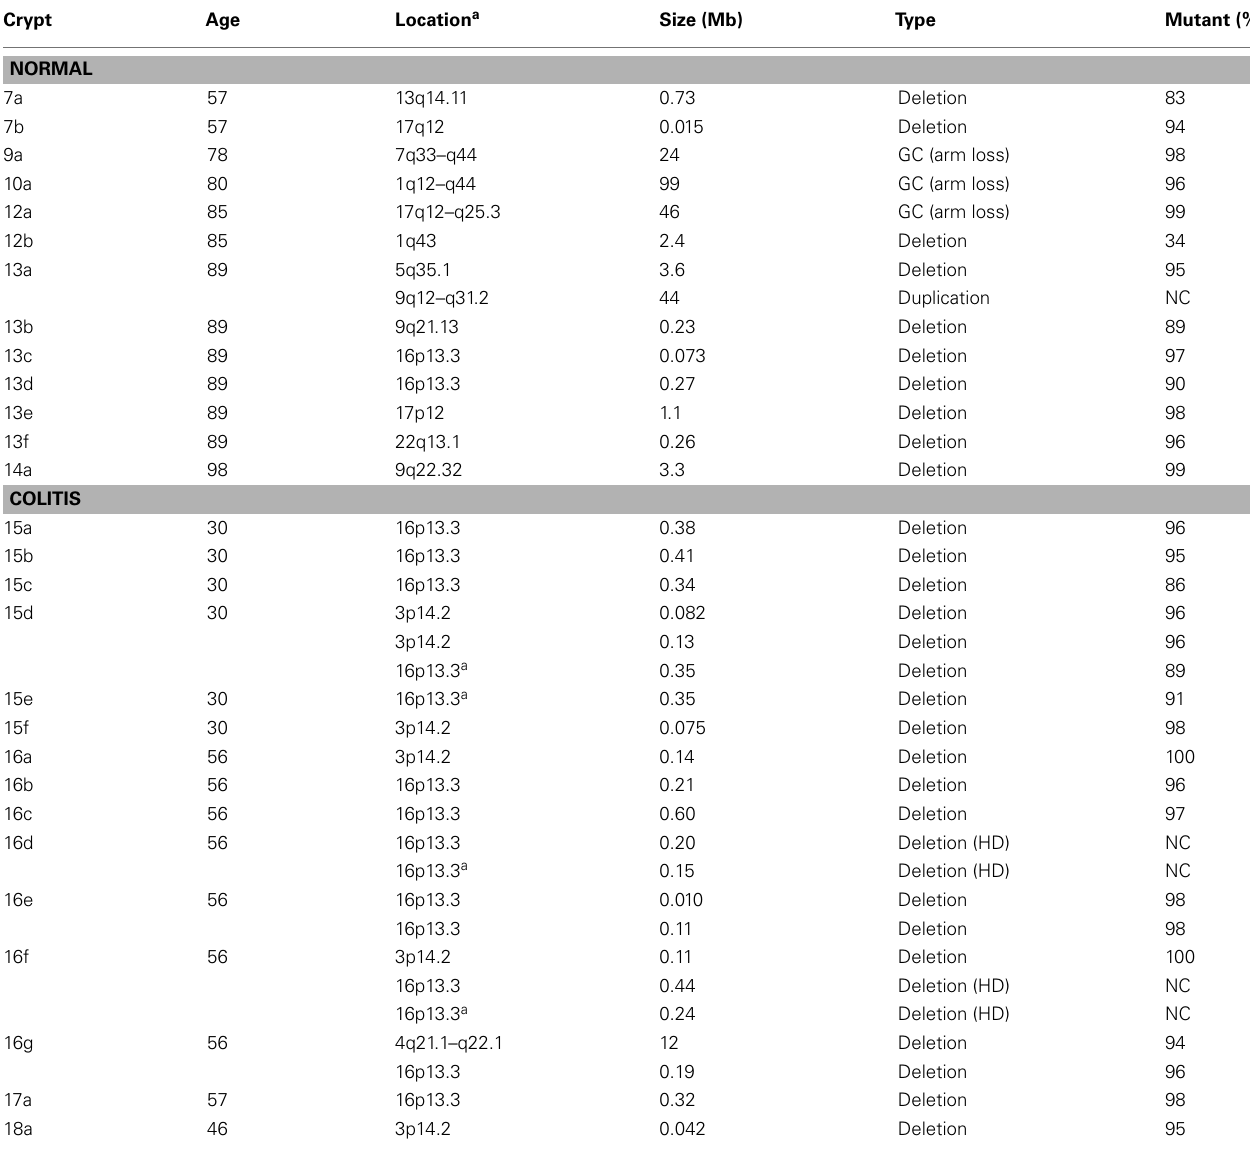
Table 2 | Chromosome copy number alteration